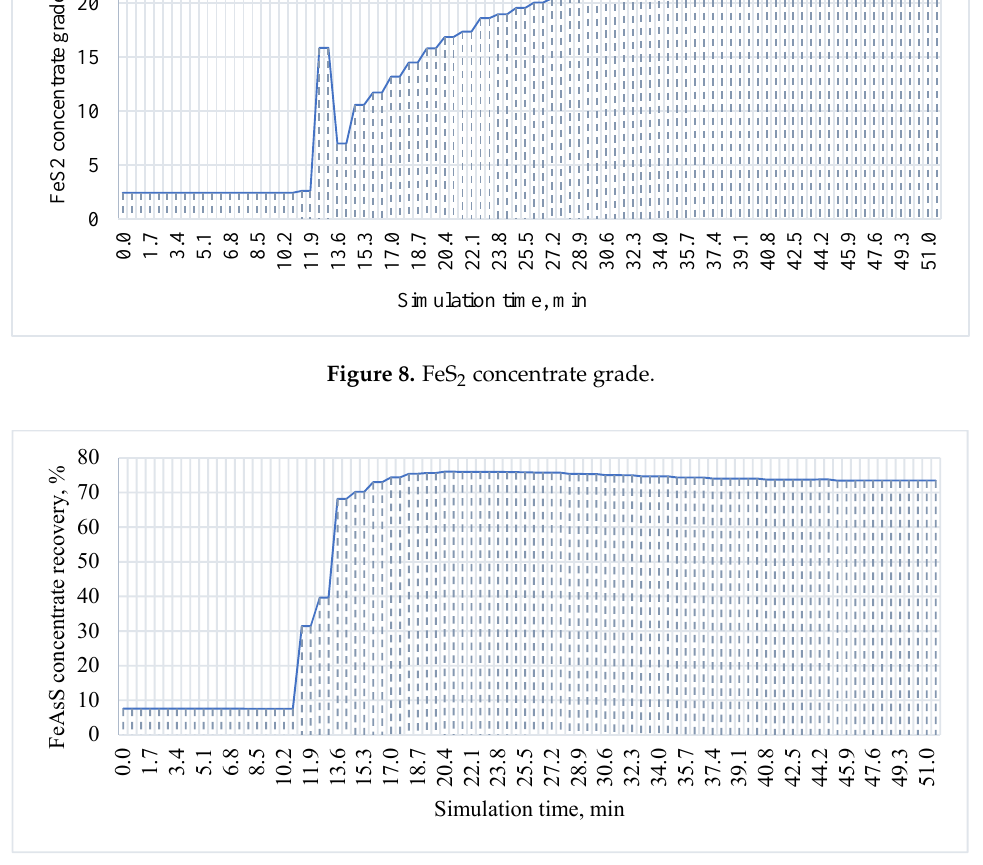
Figure 9. FeAsS concentrate recovery.